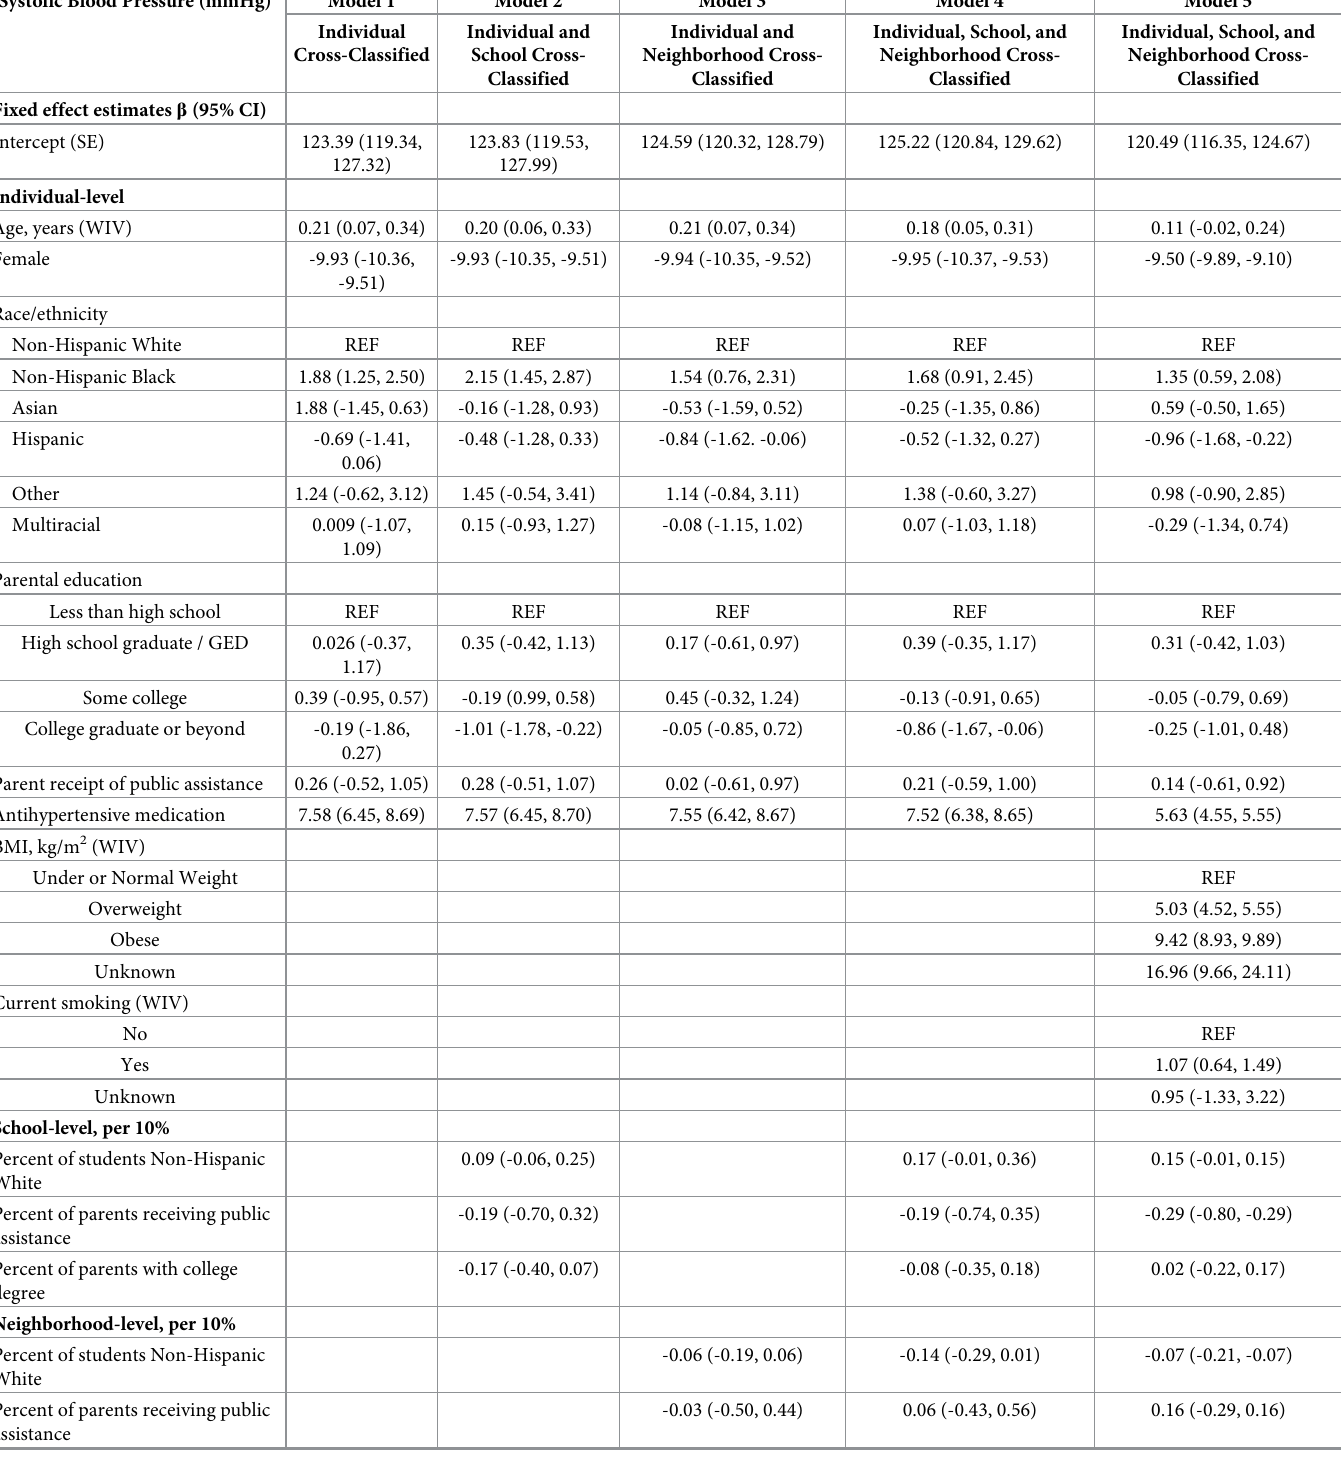
Table 3. Linear cross-classified multilevel models (CCMM) predicting systolic blood pressure from individual-, school- and neighborhood-level factors in the National Longitudinal Study of Adolescent to Adult Health, Wave IV (WIV), 2008–2009 (N =